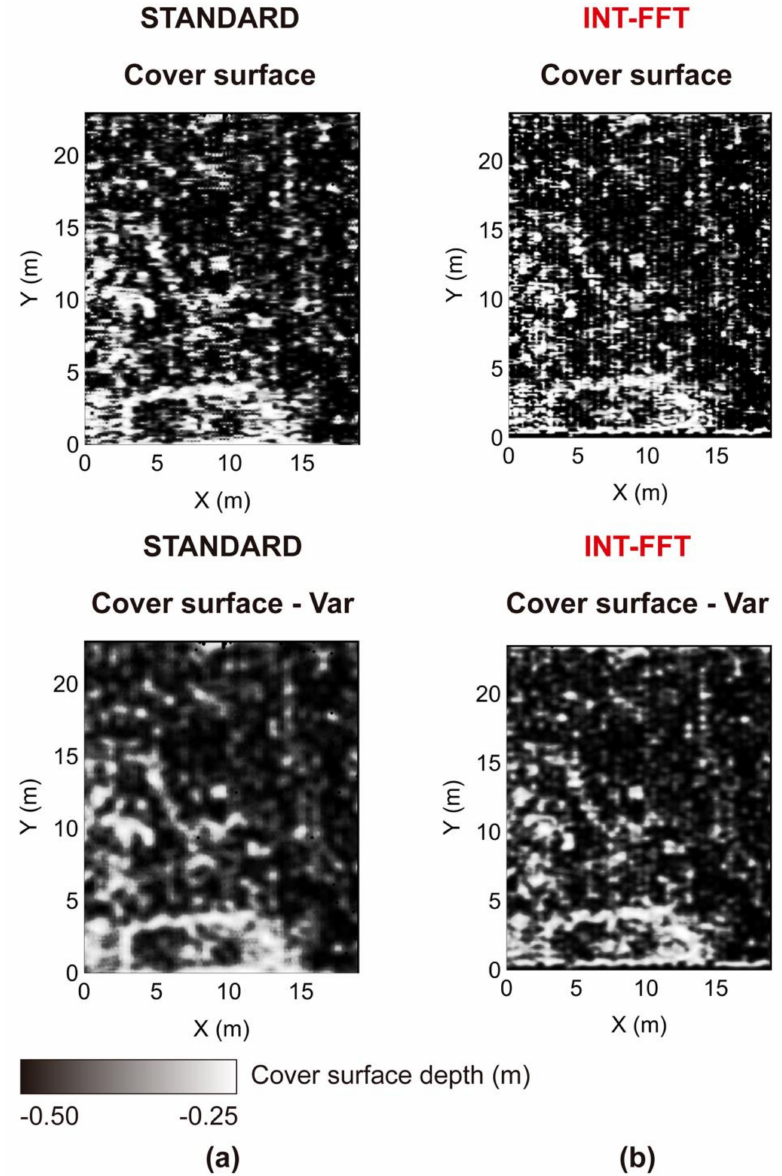
Figure 13. Cover surfaces obtained from several depth slices. ( a ) Standard processing flow. ( b ) Using the INT-FFT algorithm. This type of output increases the perception of the presence of buried structures. In the interpolated data, we observe vertical strips. The directional filter removes